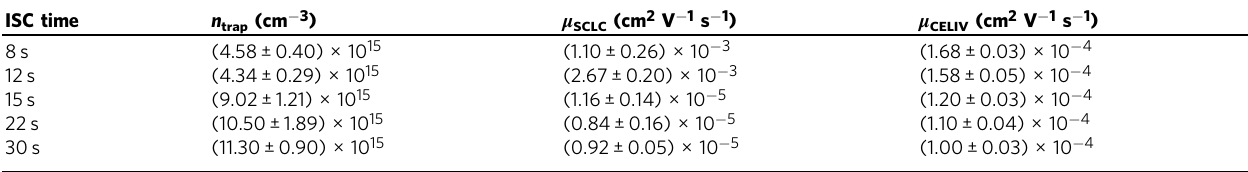
Table 1 Statistic results of SCLC and MIM-CELIV measurements. ISC